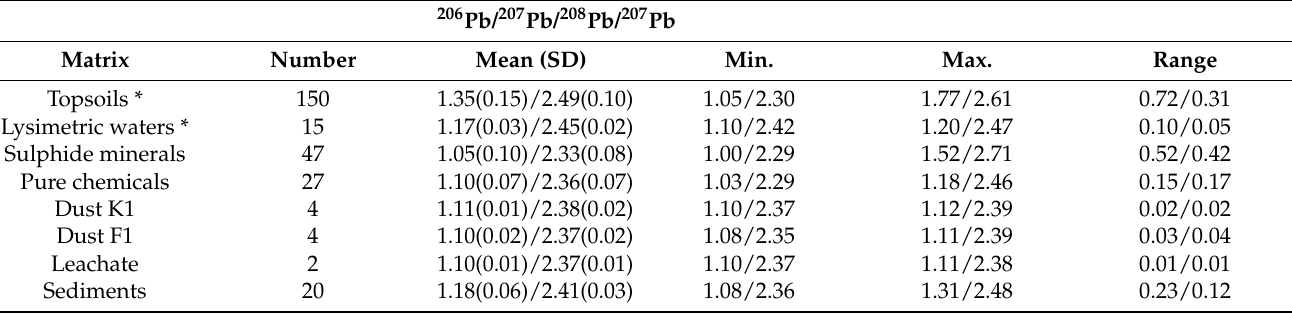
Table 3. Lead isotopic composition in environmental, geological, and industrial samples. Matrices marked * reported from previous studies [22].